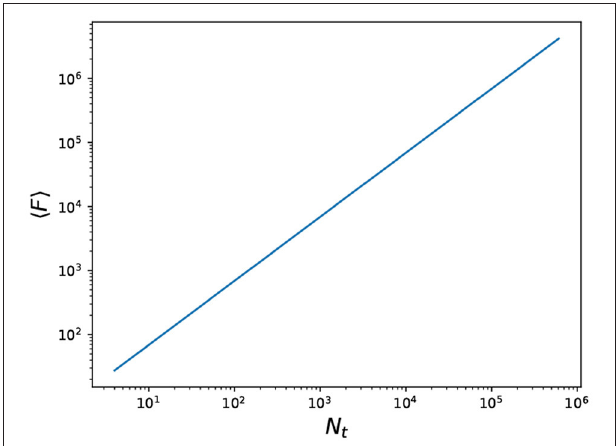
FIGURE 3 | Mean first-passage time for scale-free network vs. the number of vertices N t